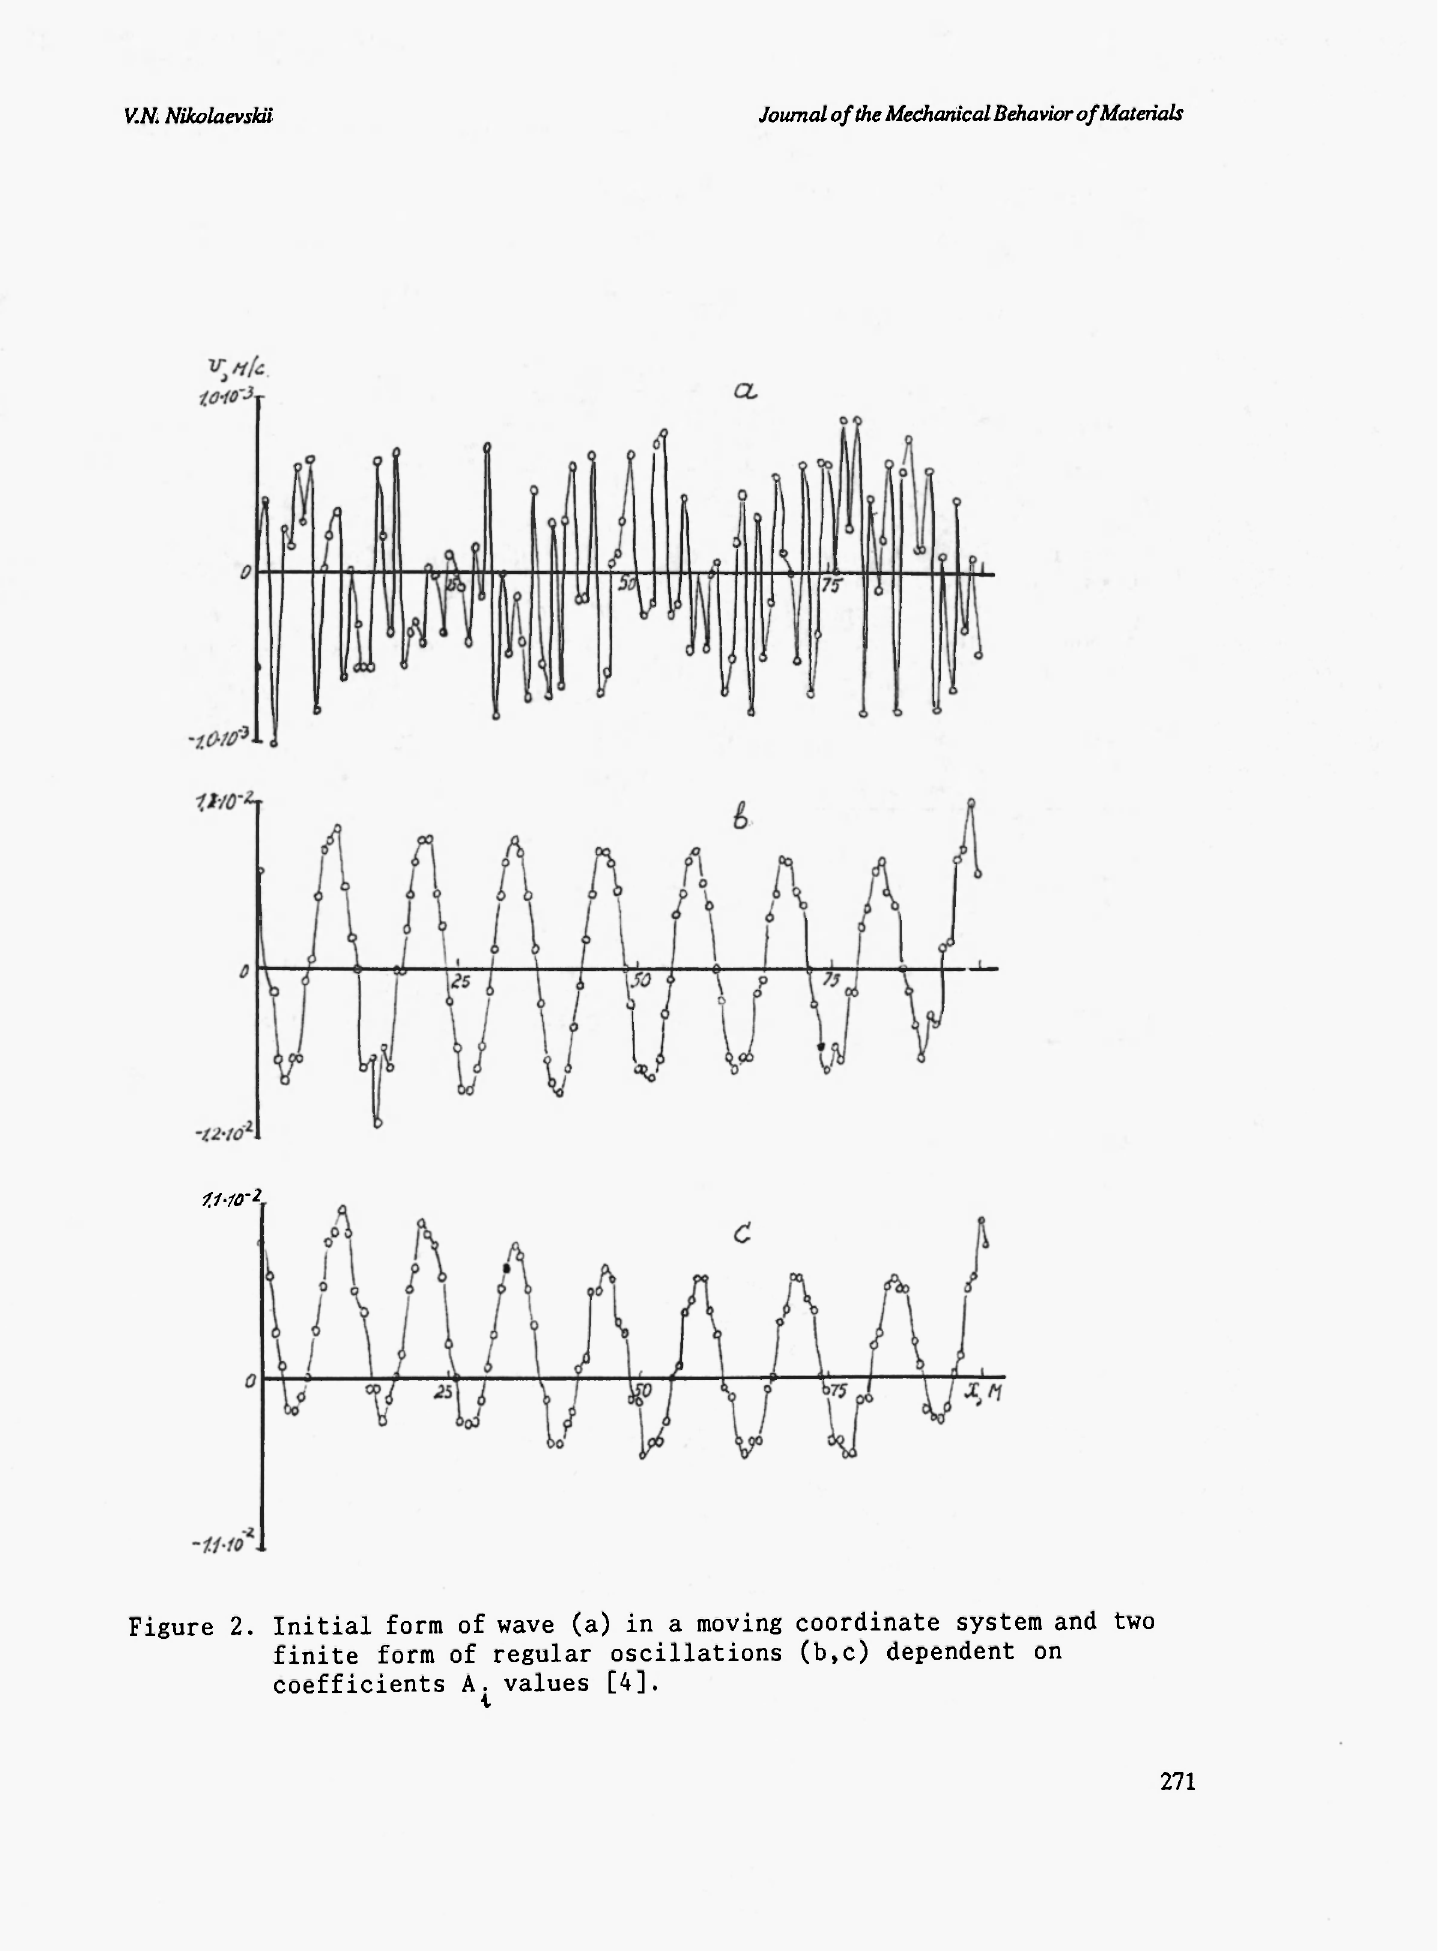
Figure 2. Initial form of wave (a) in a moving coordinate system and two finite form of regular oscillations (b,c) dependent on coefficients A^ values